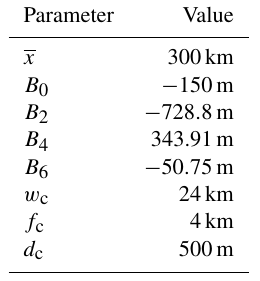
Table 1. Parameter values for the MISMIP+ bedrock geometry Parameter